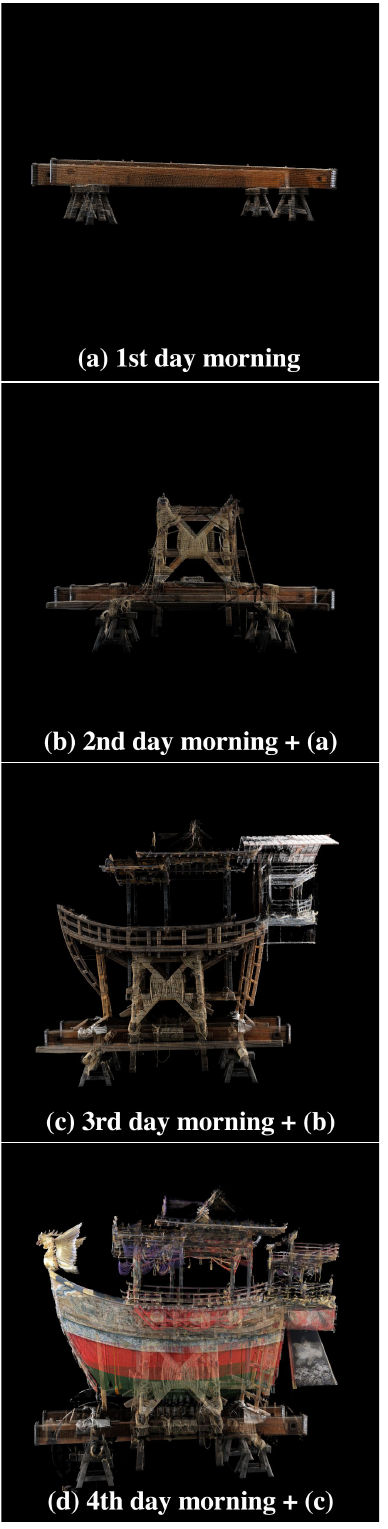
Figure 8. Cumulative fused visualizations based on time-series data acquired during and after the reconstruction process. The acquired point clouds are fused cumulatively and accumulated.